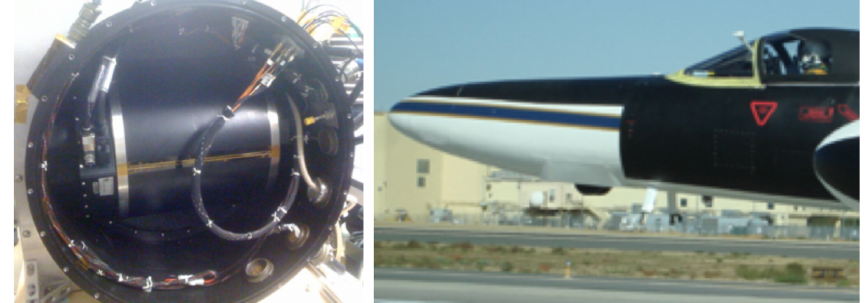
Figure 1. Left: Pressure vessel and cylindrical drum housing the AirMSPI camera. Right: Fig. 1. Left panel: pressure vessel and cylindrical drum housing the AirMSPI camera. Right panel: AirMSPI installed in the nose of the ER-2. AirMSPI installed in the nose of the ER-2. The instrument is visible protruding below the The instrument is visible protruding below the fuselage. fuselage. Table 1. Top-level characteristics of the AirMSPI focal plane